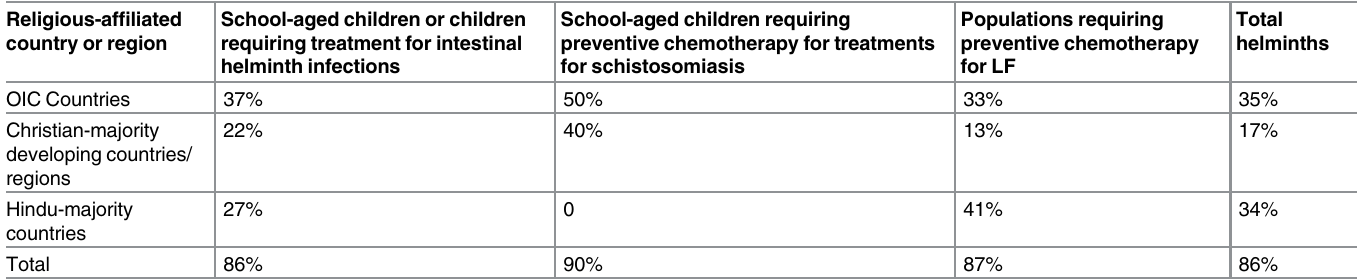
Table 3. Percentage of NTDs in OIC countries, Christian-majority developing countries and regions, and the three Hindu-majority